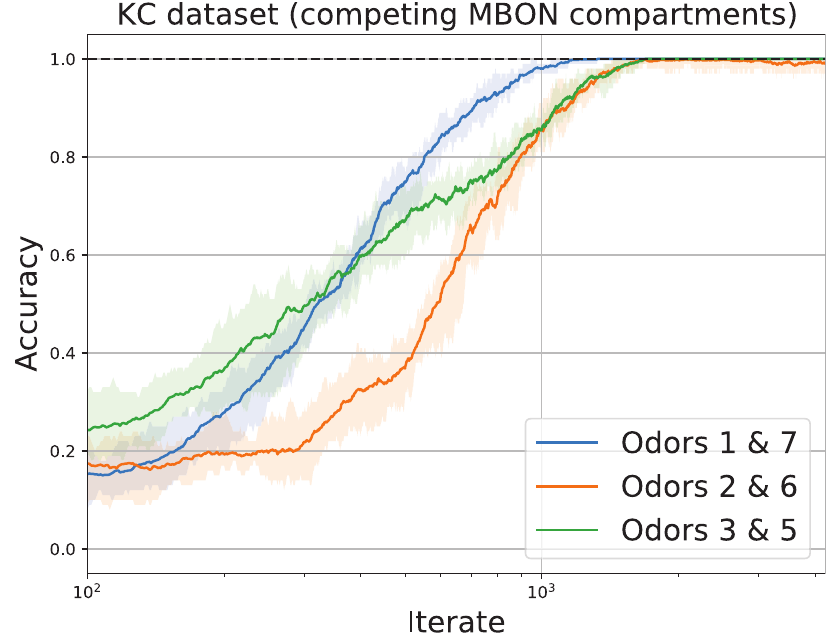
Fig 4. Performance of competing MBONs. Accuracy of 2 parallel runs of Algorithm 1 on the KC dataset to classify odors as aversive, attractive or neutral. Each line denotes the mean accuracy over 10 runs. Each shaded region indicates the area between the minimum and maximum accuracy over 10